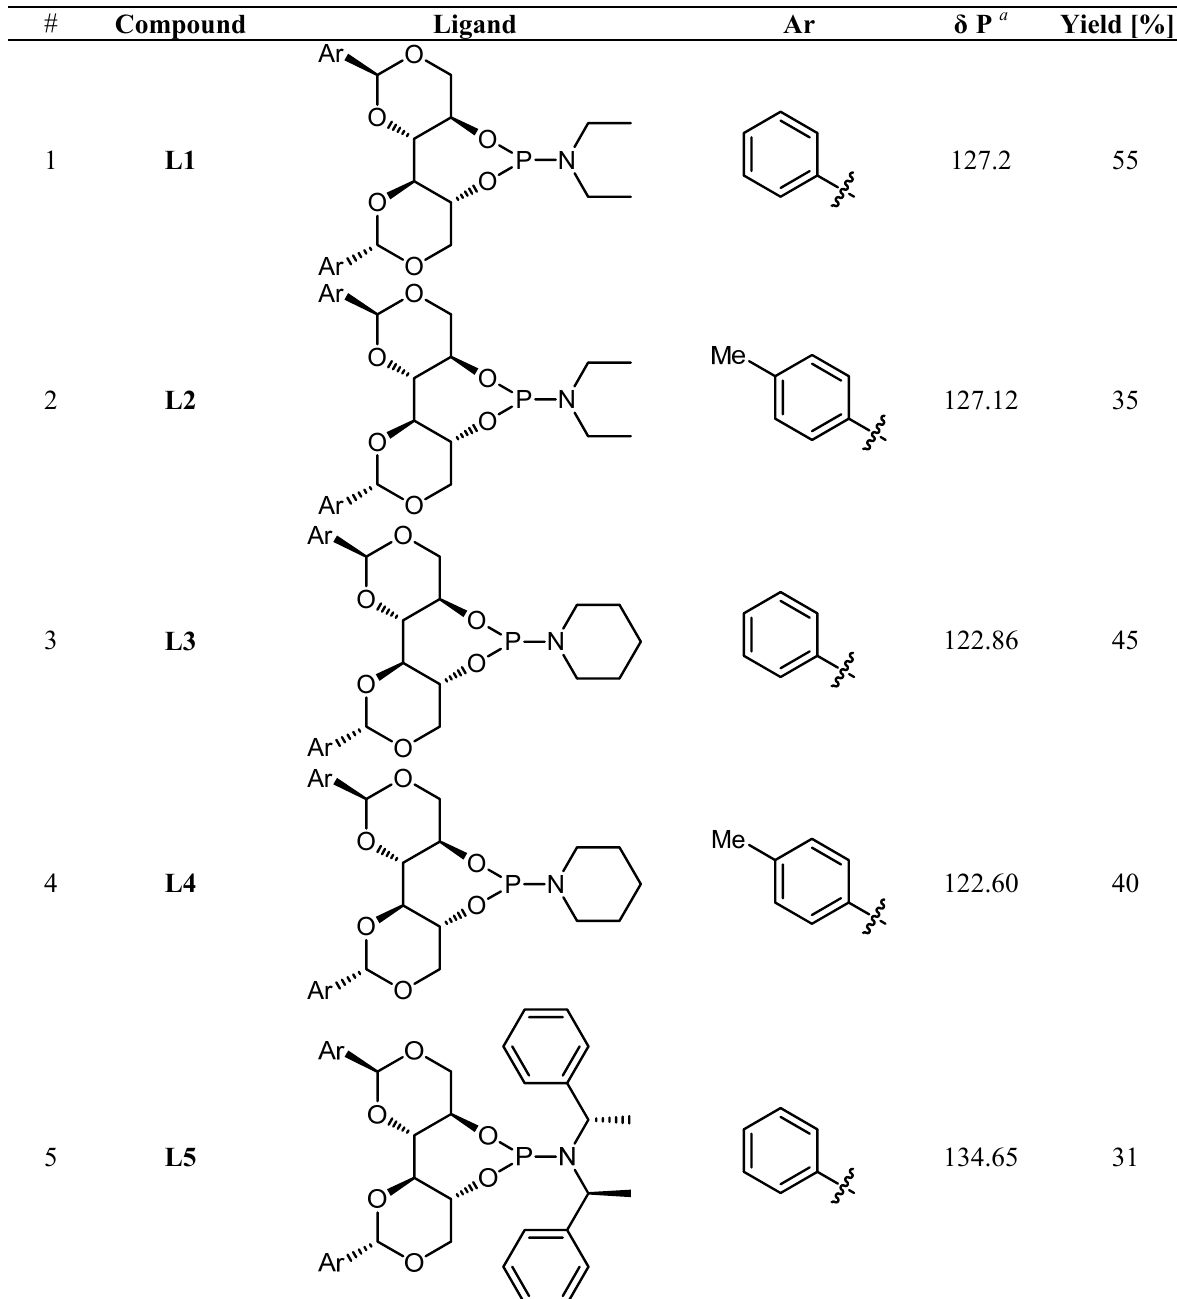
Table 1. Results of synthesis of chiral phosphoramidite